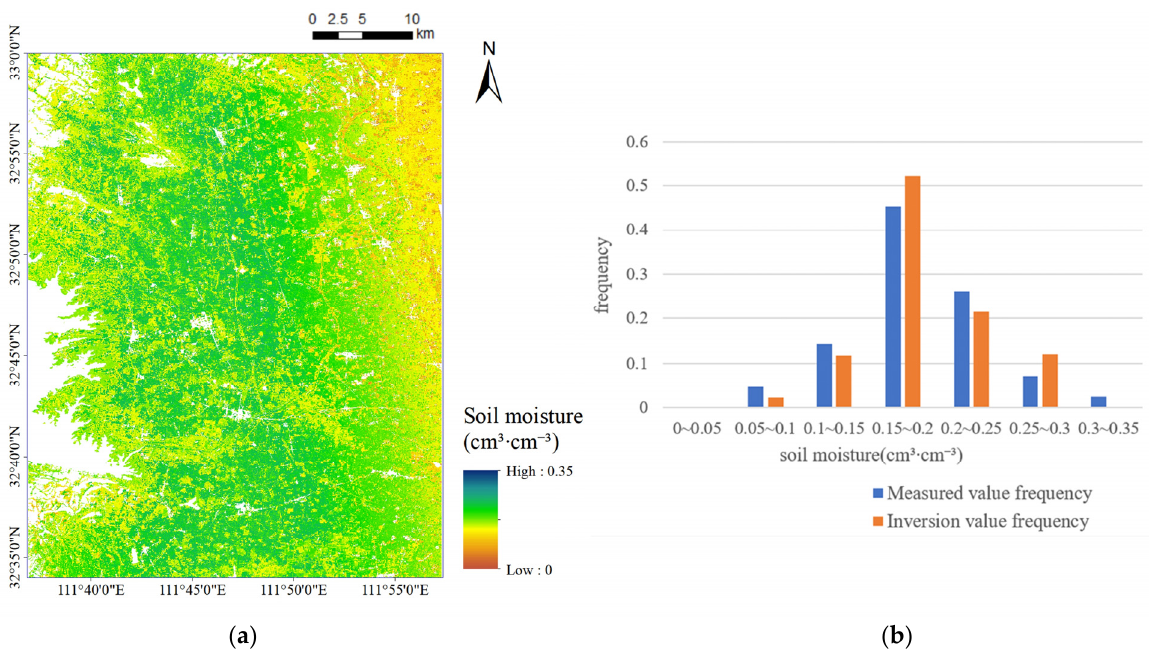
Figure 6. Inversion results of regional SSM in the study area on 5 October 2021: ( a ) spatial distribution of retrieved SSM; ( b ) frequency distribution of retrieved and measured SSM.